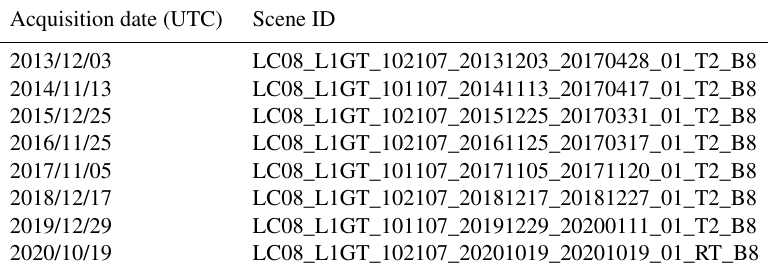
Table A1. Information for the Landsat 8 images used for velocity mapping in Experiment